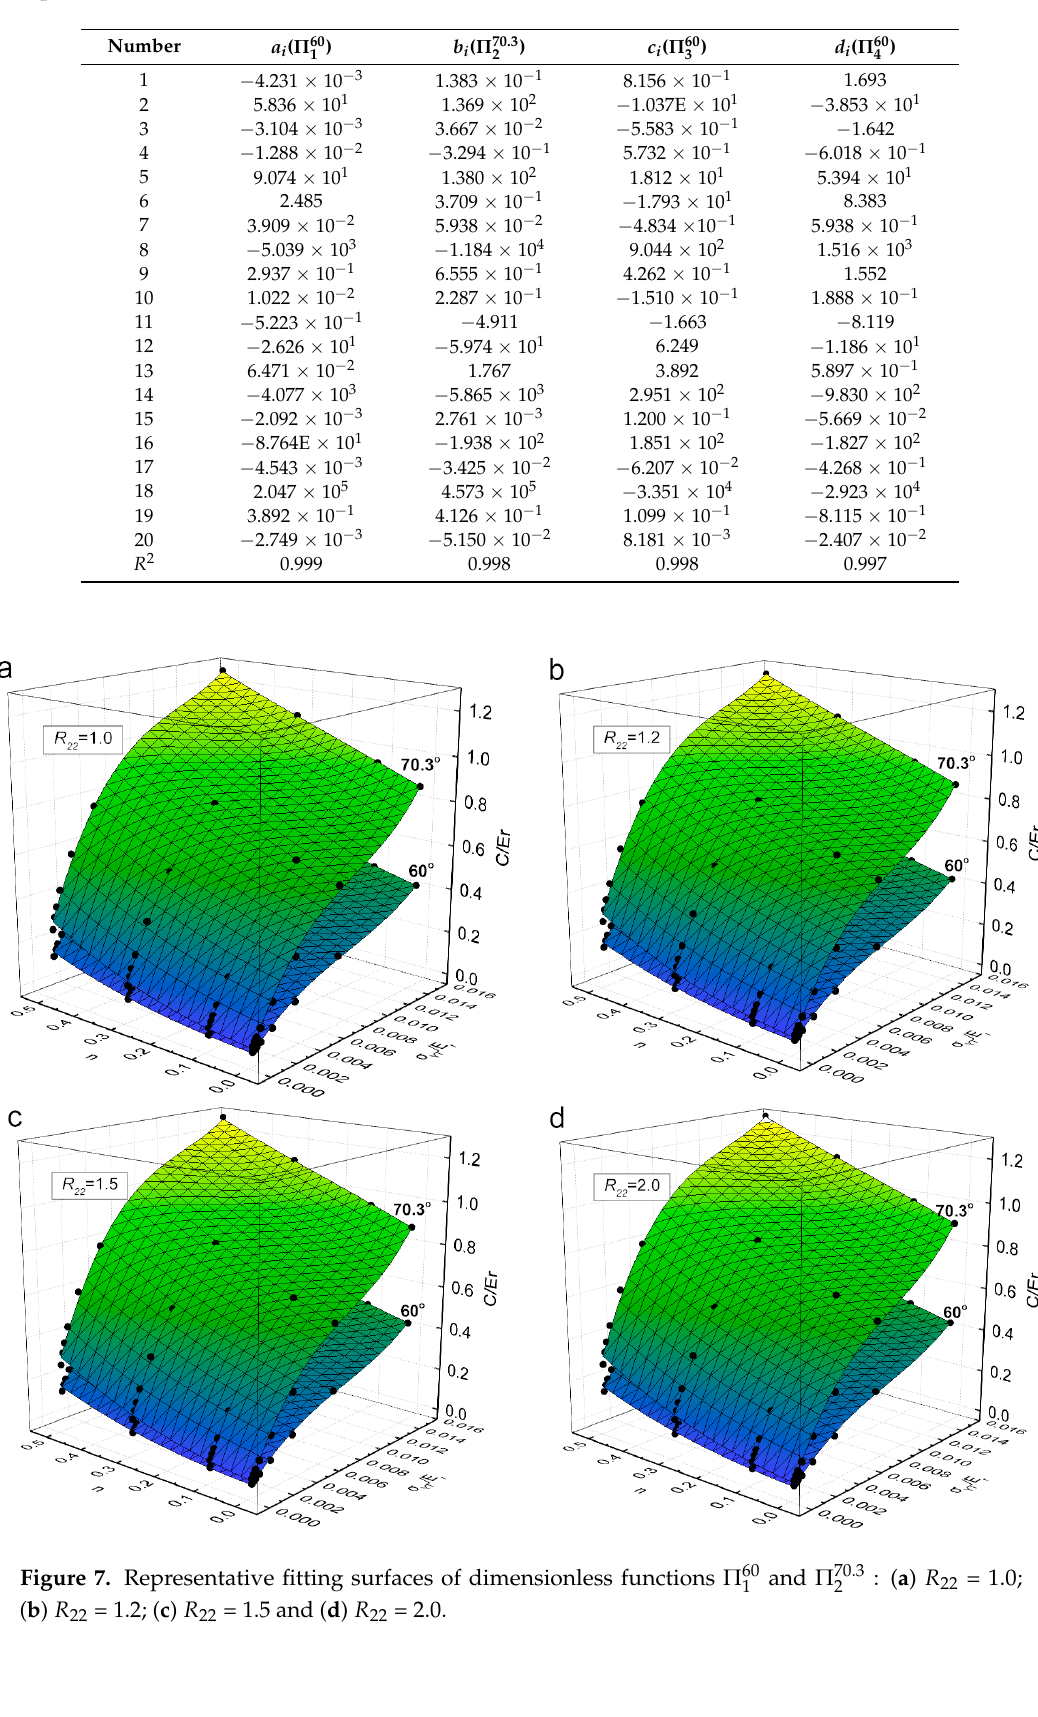
, Π 70.3 , Π 60 and Π 60 in 2 3 1 4